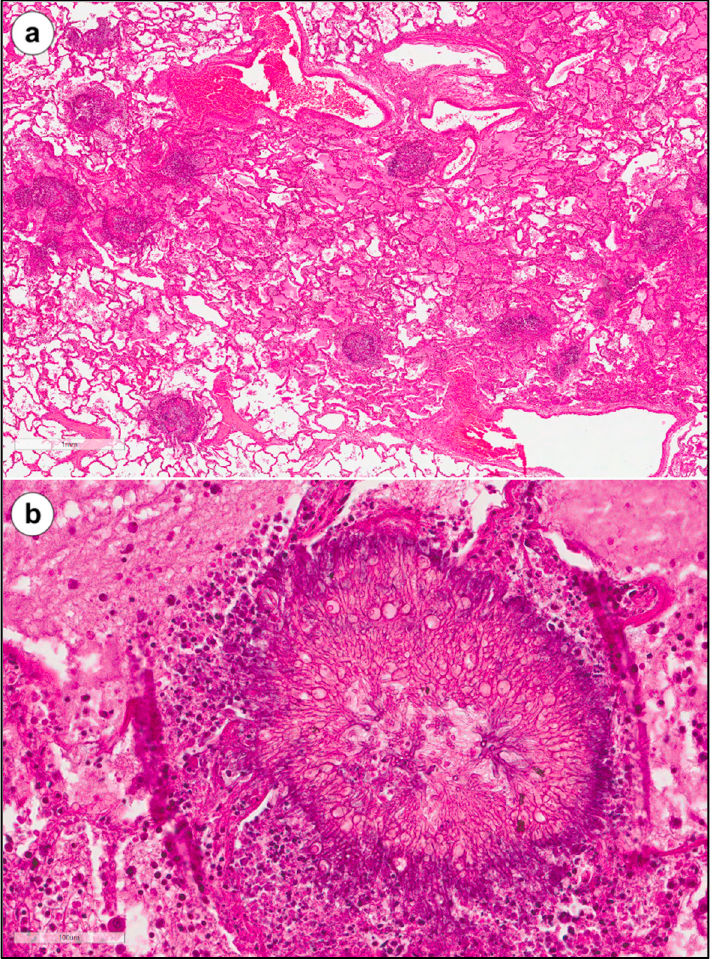
Figure 2. An index case of CAPA (60-year-old man) from the Padova cohort. The lung parenchyma showed oedema and several nodular aggregates that, at higher magnification, were composed of hyphae morphologically compatible with Aspergillus spp. (( a , b ) hematoxylin and eosin, original magnification ×20 and ×200, respectively).